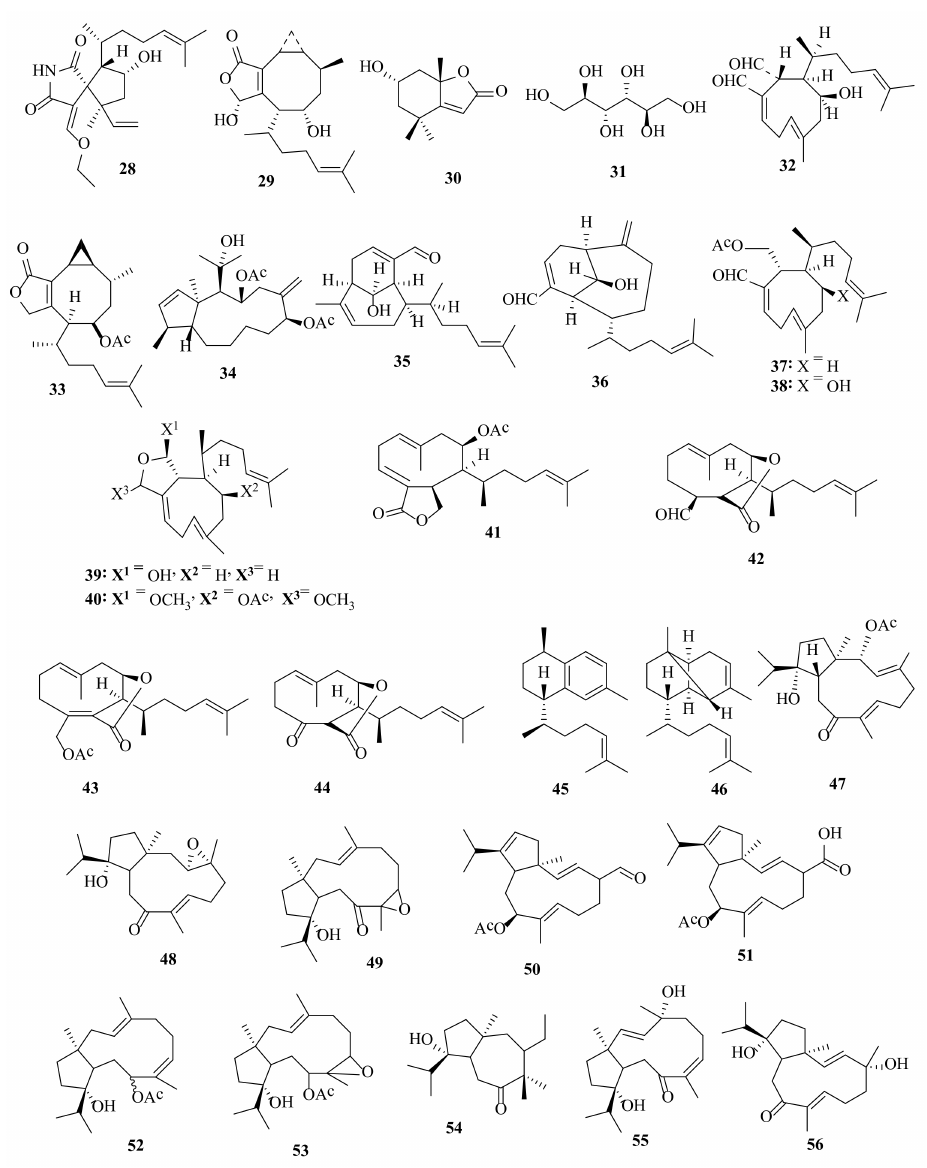
Figure 3. Chemical structures of compounds 28 – 56 . The spirosuccinimide alkaloid 28 , thediterpenes 29 – 30 , and the sugar 31 were isolated from D. coriacea , the diterpenes 32 – 36 were isolated from D. crenulata , and the diterpenes 37 – 56 were isolated from D. dichotoma. The configuration of all stereocenters in each compound is shown as given in the